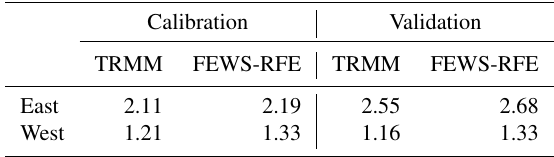
Table 5. GRACE objective functions (WRMSD [–]) for the two models for the calibration and validation